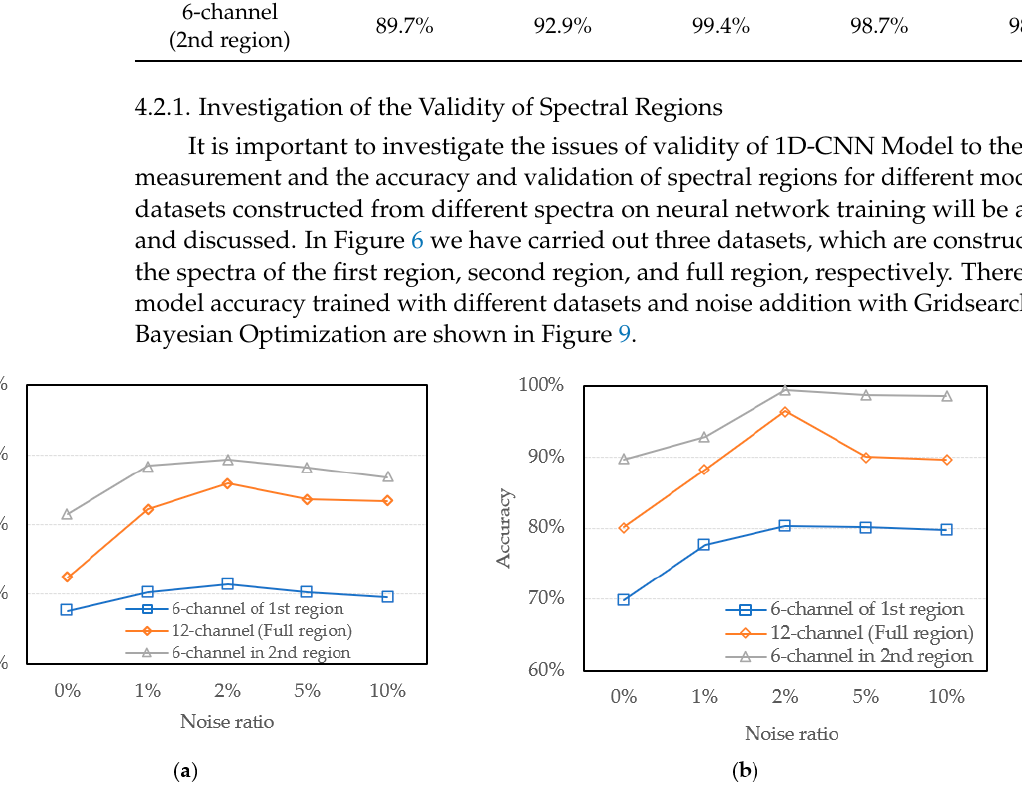
Figure 9. Model accuracy trained with different dataset and noise addition ( a ) GridsearchCV ( b ) Bayesian optimization.